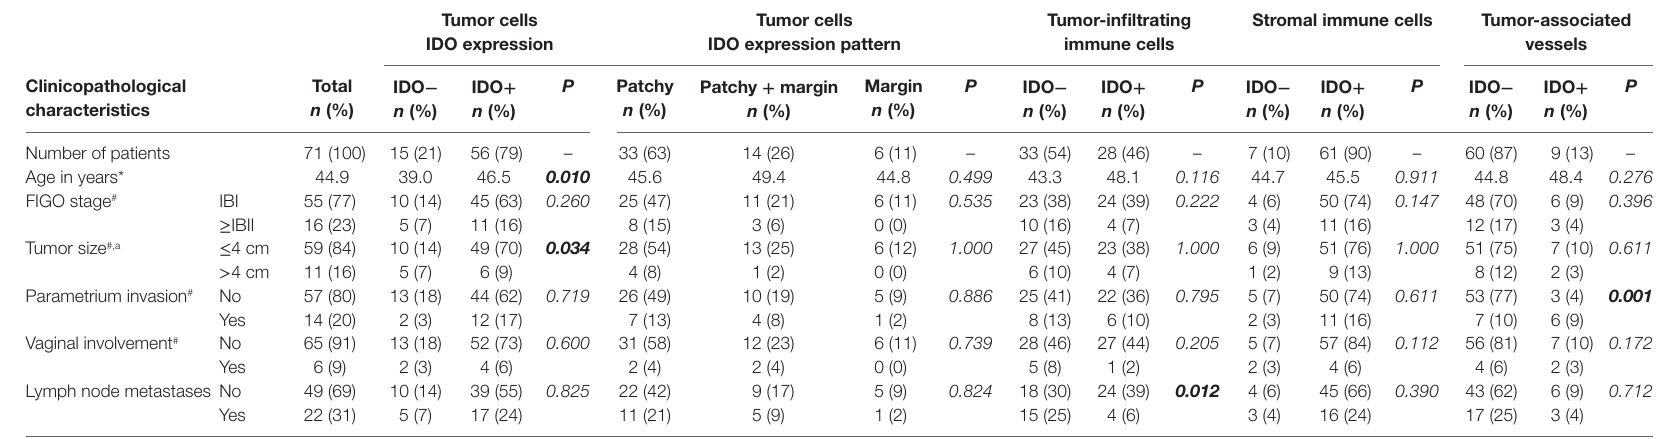
FIGO: International Federation of Gynecology and Obstetrics. a Of one case we do not have information on tumor size. # P-value measured with Asymptotic Pearson’s and Fisher’s exact test was used when counts were < 5. *P-value was calculated with Mann–Whitney U test. IDO + , IDO-positive; IDO − , IDO-negative. NB: in three cases, we found it difficult to score IDO + tumors for their expression pattern (patchy/margin) due to small tumor fields. In some cases (n = 10), we found it difficult to distinguish between IDO-positive immune cells and IDO-positive tumor cells and excluded those cases for scoring expression in infiltrating cells. In some cases (n = 3), we found the staining pattern not convincing due to small stromal fields in the stained tissue section and excluded those cases for scoring stromal IDO + cells. In some cases (n = 2), we found it difficult to score IDO expression in vessels and excluded